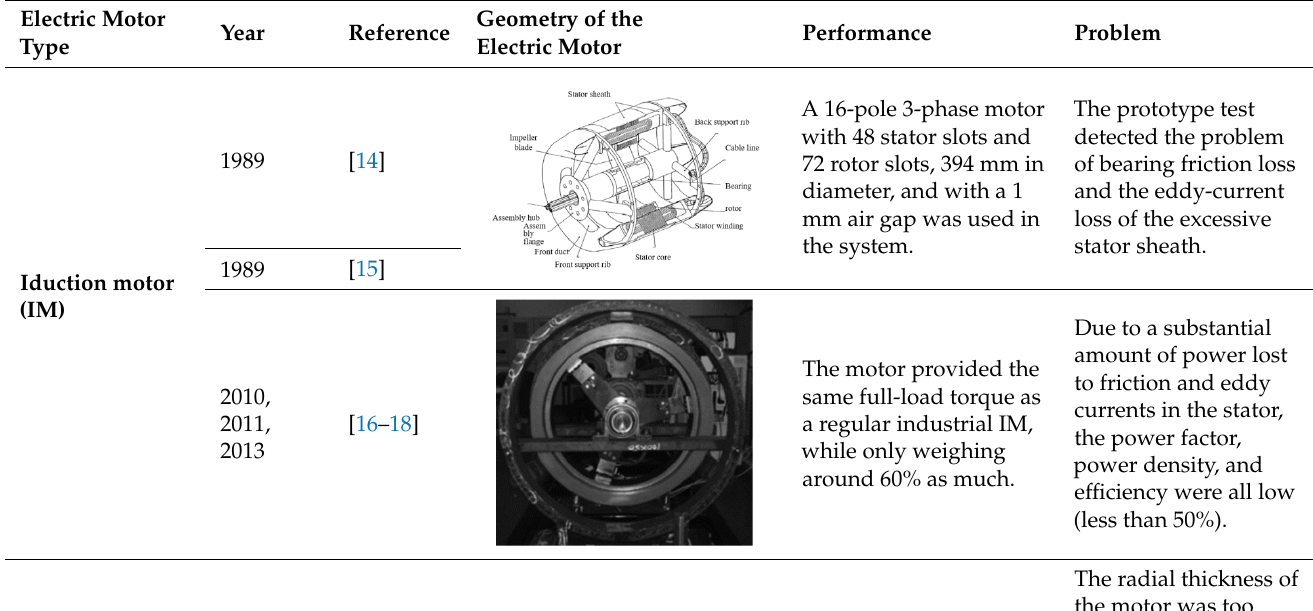
Table 1. Types of electric motors applicable to IMPs.